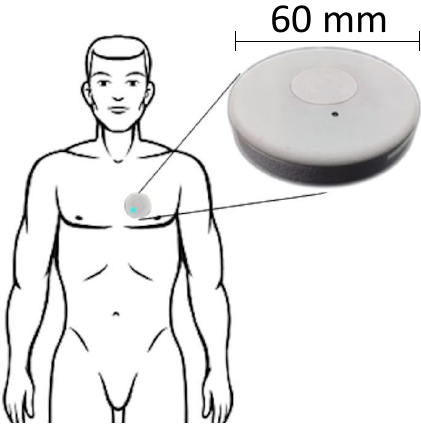
Figure 1. Soundi wearable